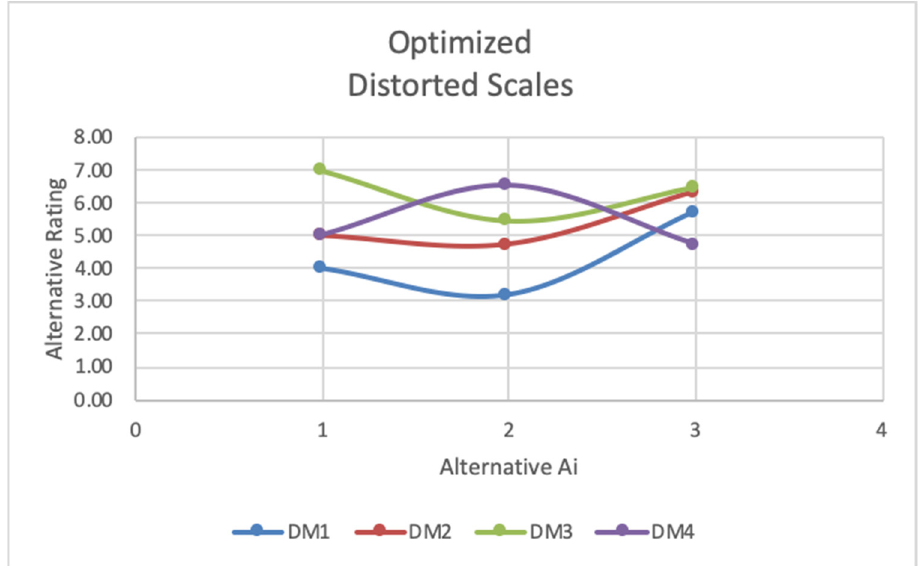
Figure 13. Case #18 adjusted distorted scales (extreme bias).